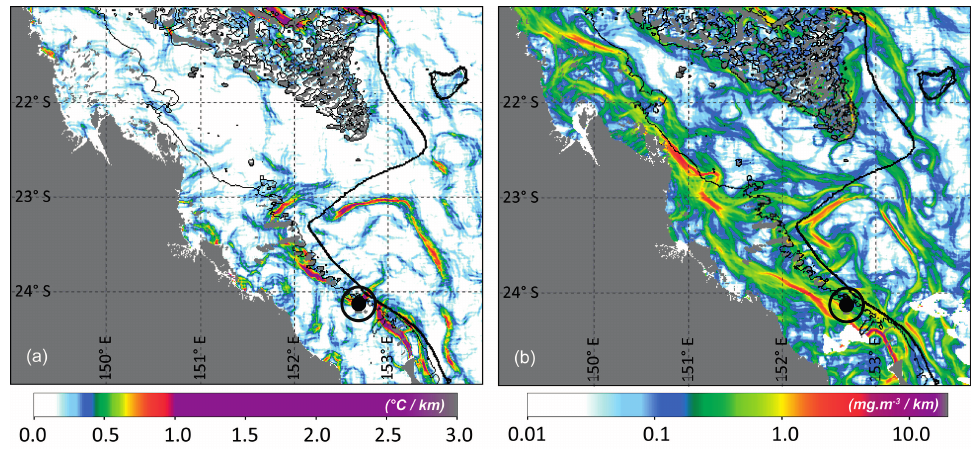
Figure 6. MODIS images of frontal gradient intensity for the southern GBR for 2 to 4 February 2013 showing ( a ) sea surface temperature gradients; and ( b ) chlorophyll gradients. The black circular marker with ring shows the location of Lady Elliot Island. The 50 m (thin black) and 200 m (thick black) isobath lines are